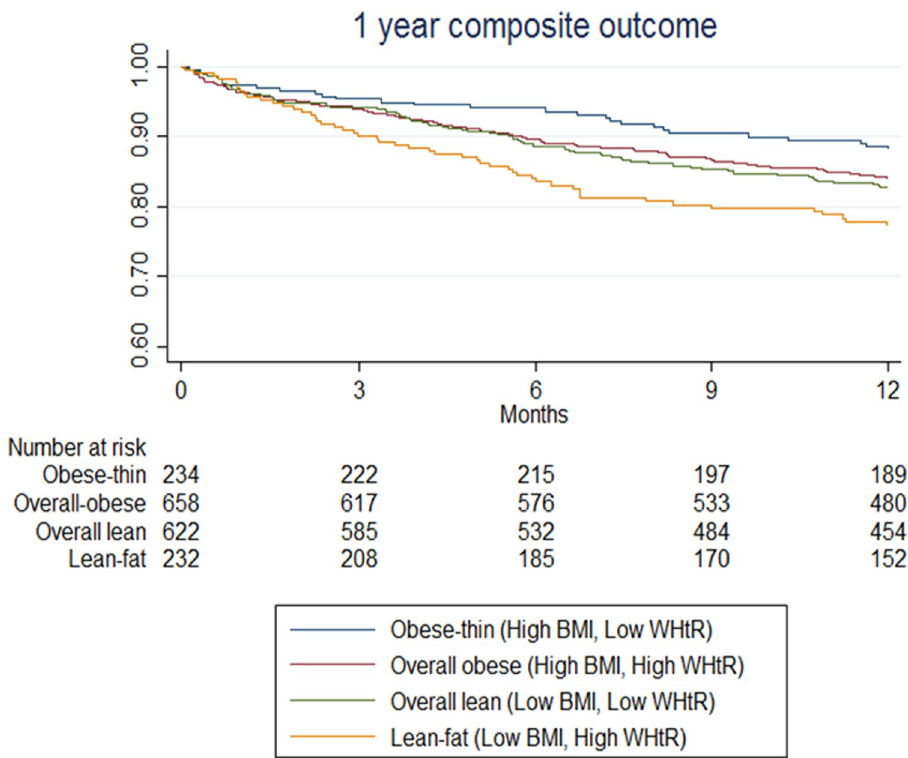
Fig 4. Kaplan–Meier survival curves of the composite outcome for combined BMI/WHtR groups. BMI, body mass index; WHtR, waist-to-height ratio.